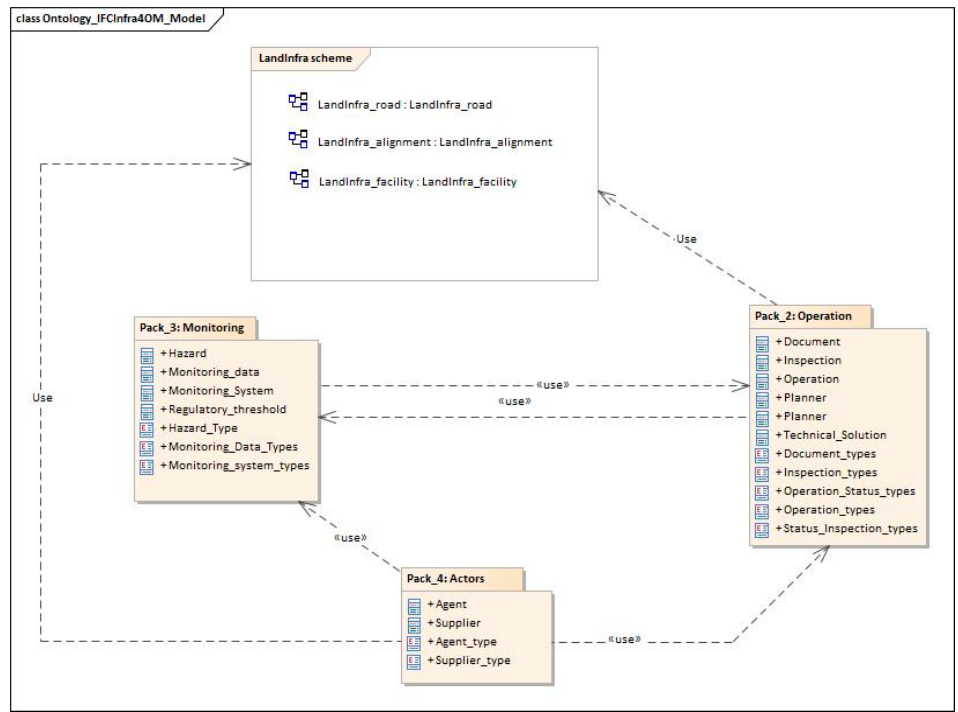
Figure 11. IFCInfra4OM Packages Diagram.